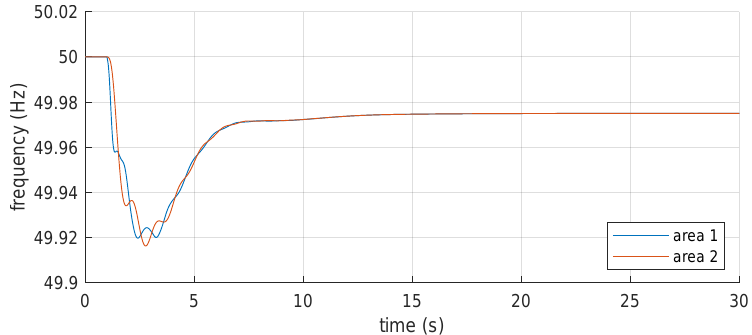
Figure 13. Grid-forming (in Area 1) and grid-following (in Area